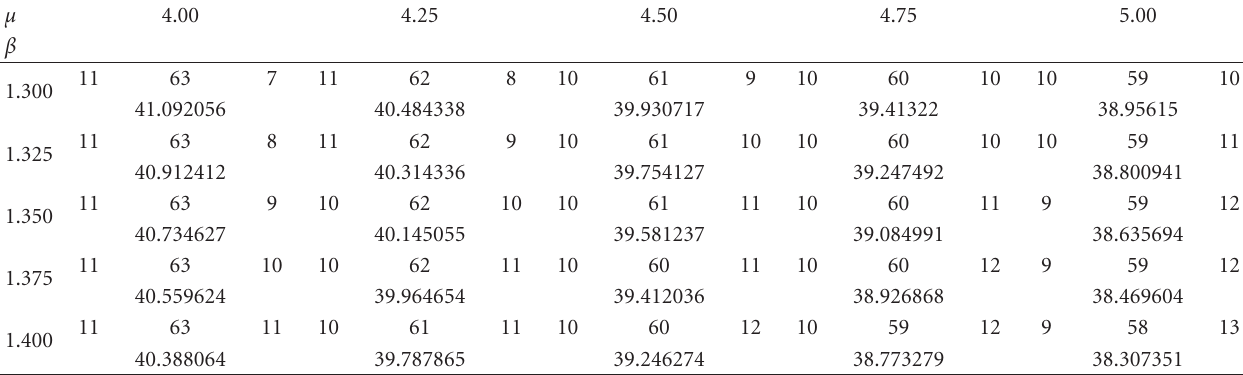
Table 7: Influence of the vacation time rate and the replenishment rate on the optimal values ( λ = 14, γ = 1 . 4, α = 4, p = 0 . 85).